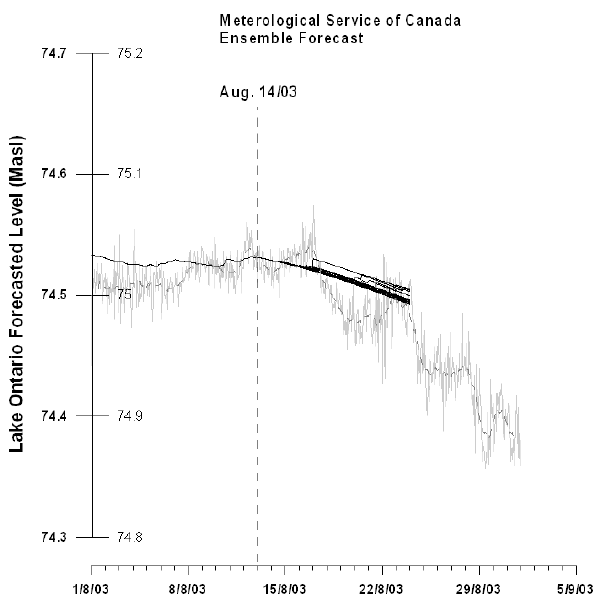
Fig. 12. Ensemble lake level estimates from the WATFLOOD simu- lation for 14 August 2003. The grey solid lines represent measured lake levels, the dashed grey line is the 5-day moving average. The black lines are the WATFLOOD ensemble simulation.